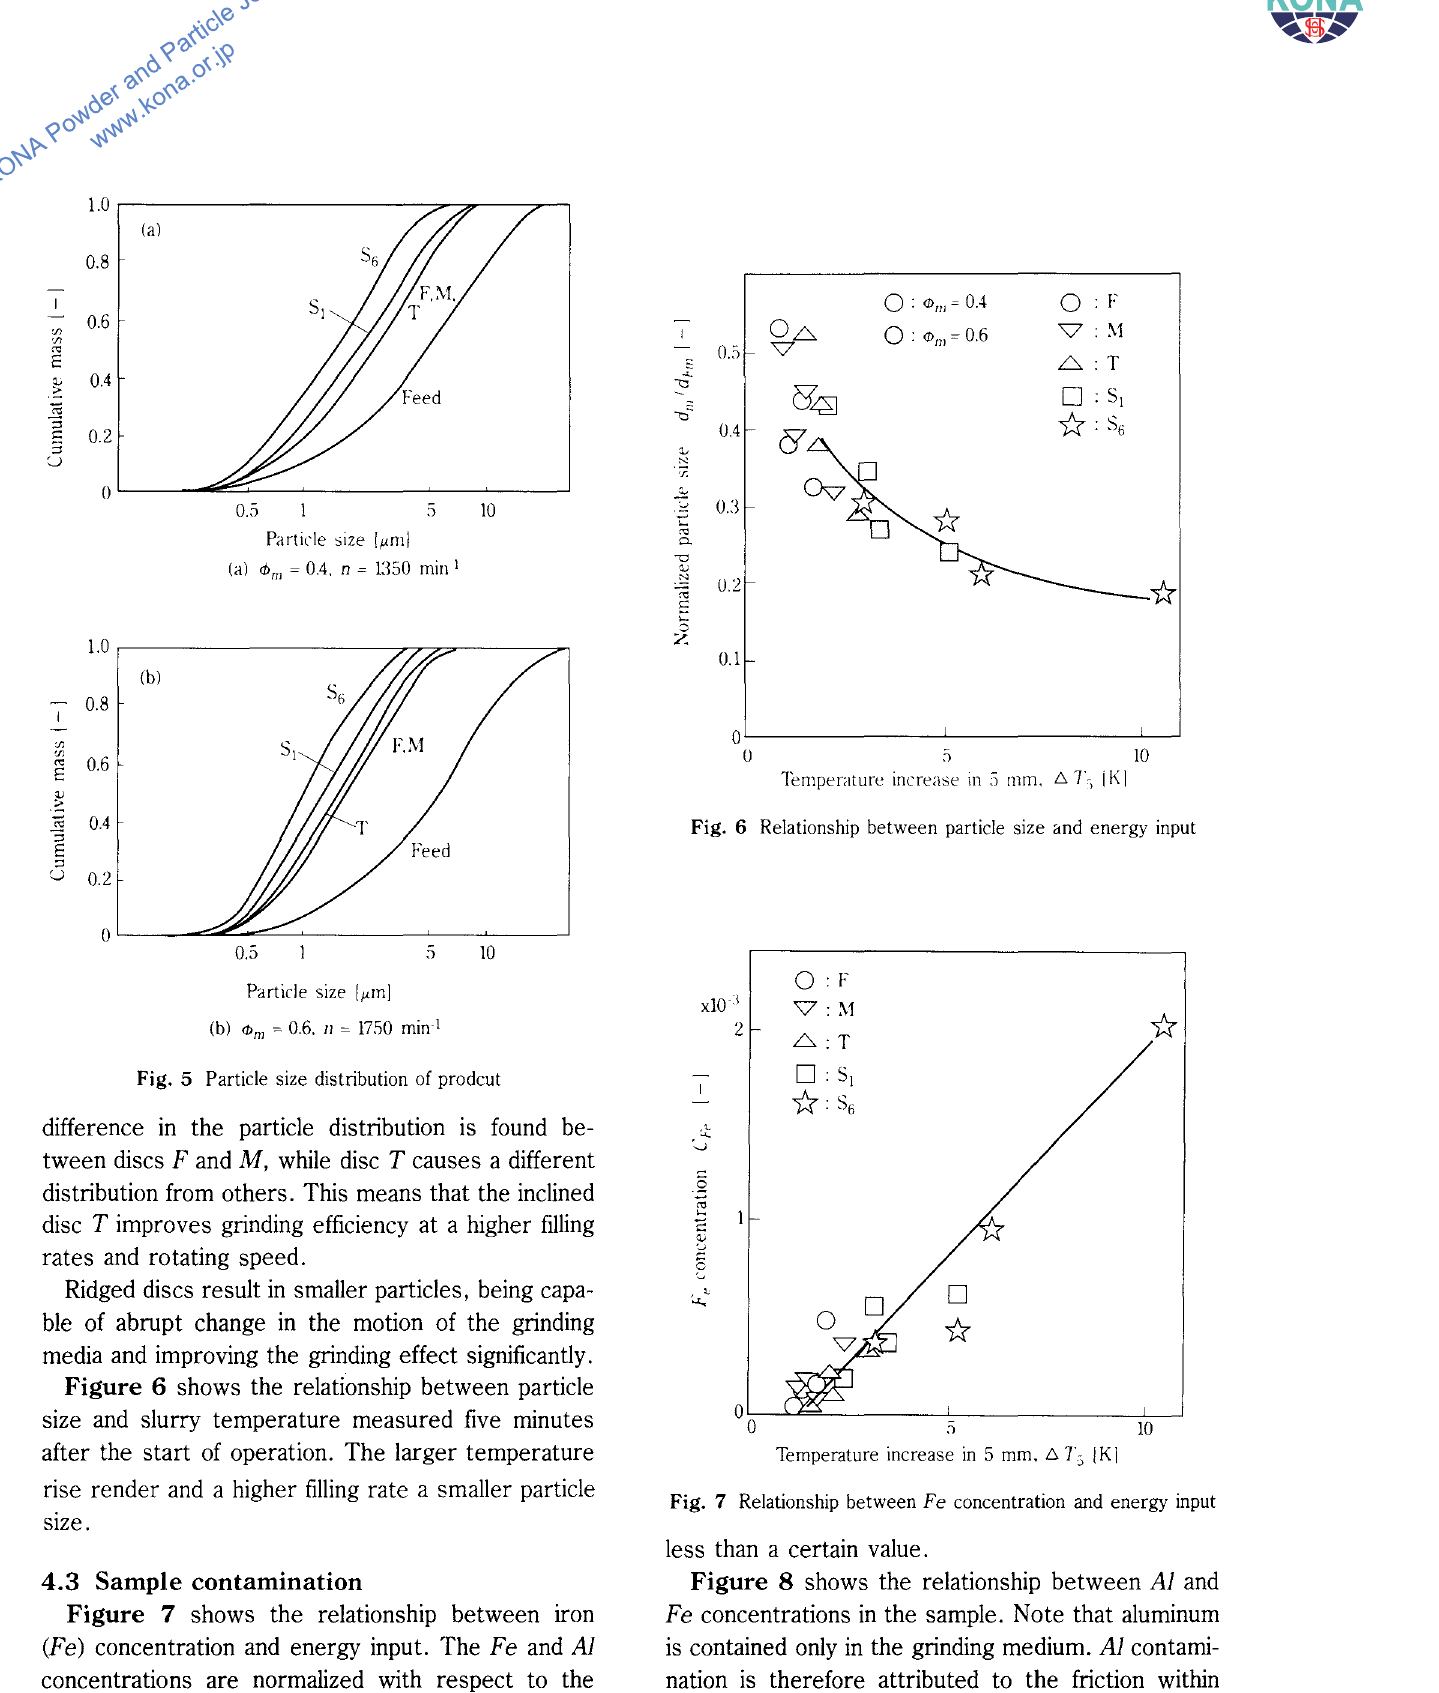
Fig. 7 Relationship between Fe concentration and energy input less than a certain